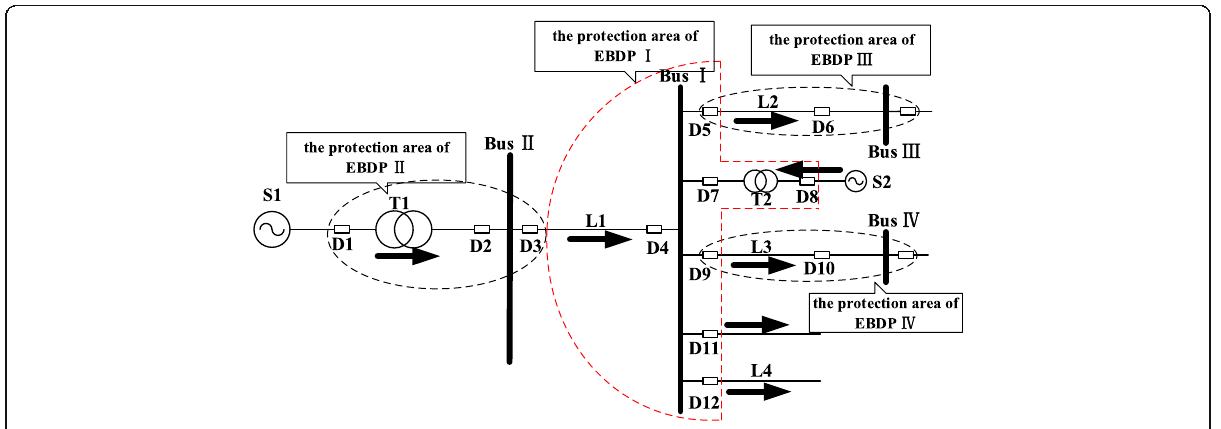
Fig. 2 Dividing of LWA and the protection areas of